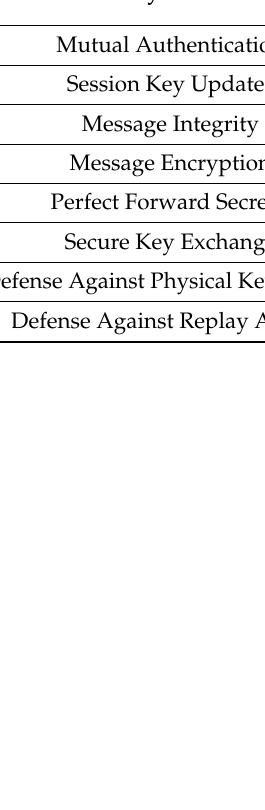
Table 1. Comparison between the existing LoRaWAN key management protocols and the proposed protocol. Security